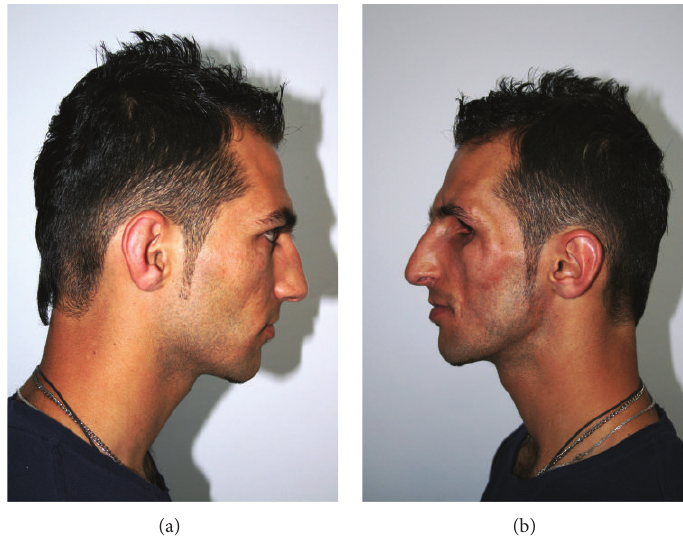
Figure 3: (a) Right view. (b) Left view.